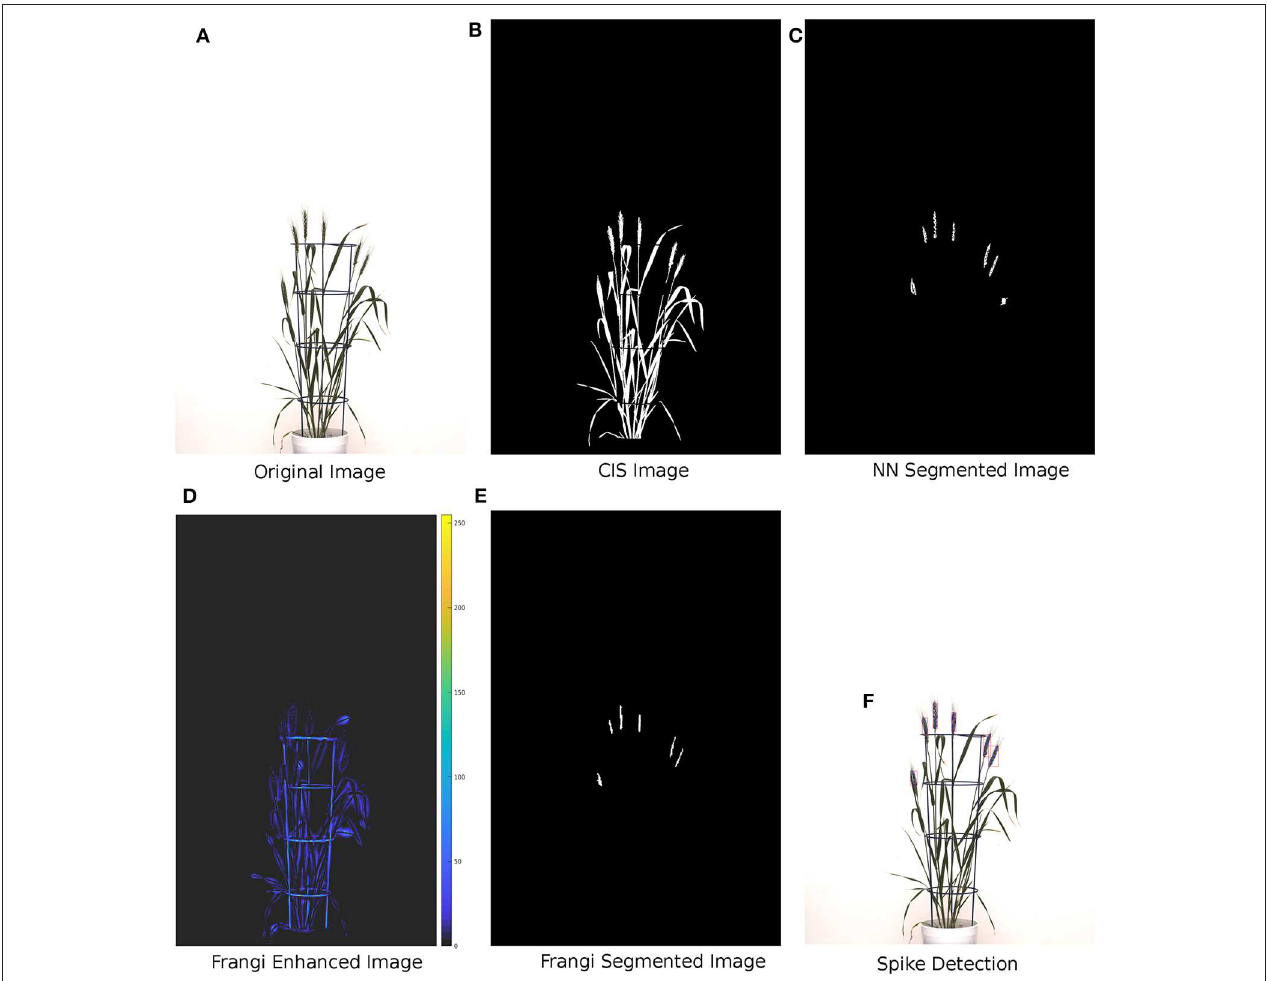
FIGURE 3 | Methodology of the proposed spike detection algorithm with example images. (A) Wheat plant with ID 1817KN373 at 150 days after sowing. (B) Green color indices-based segmented image. (C) DWT + Laws textural features-based NN segmented image. (D) Image Frangi enhanced at multiple scales and orientations. (E) Final binary segmentation: one leaf-crossing artifact is suppressed with the Frangi-enhanced image. (F) Spikes detected after morphological